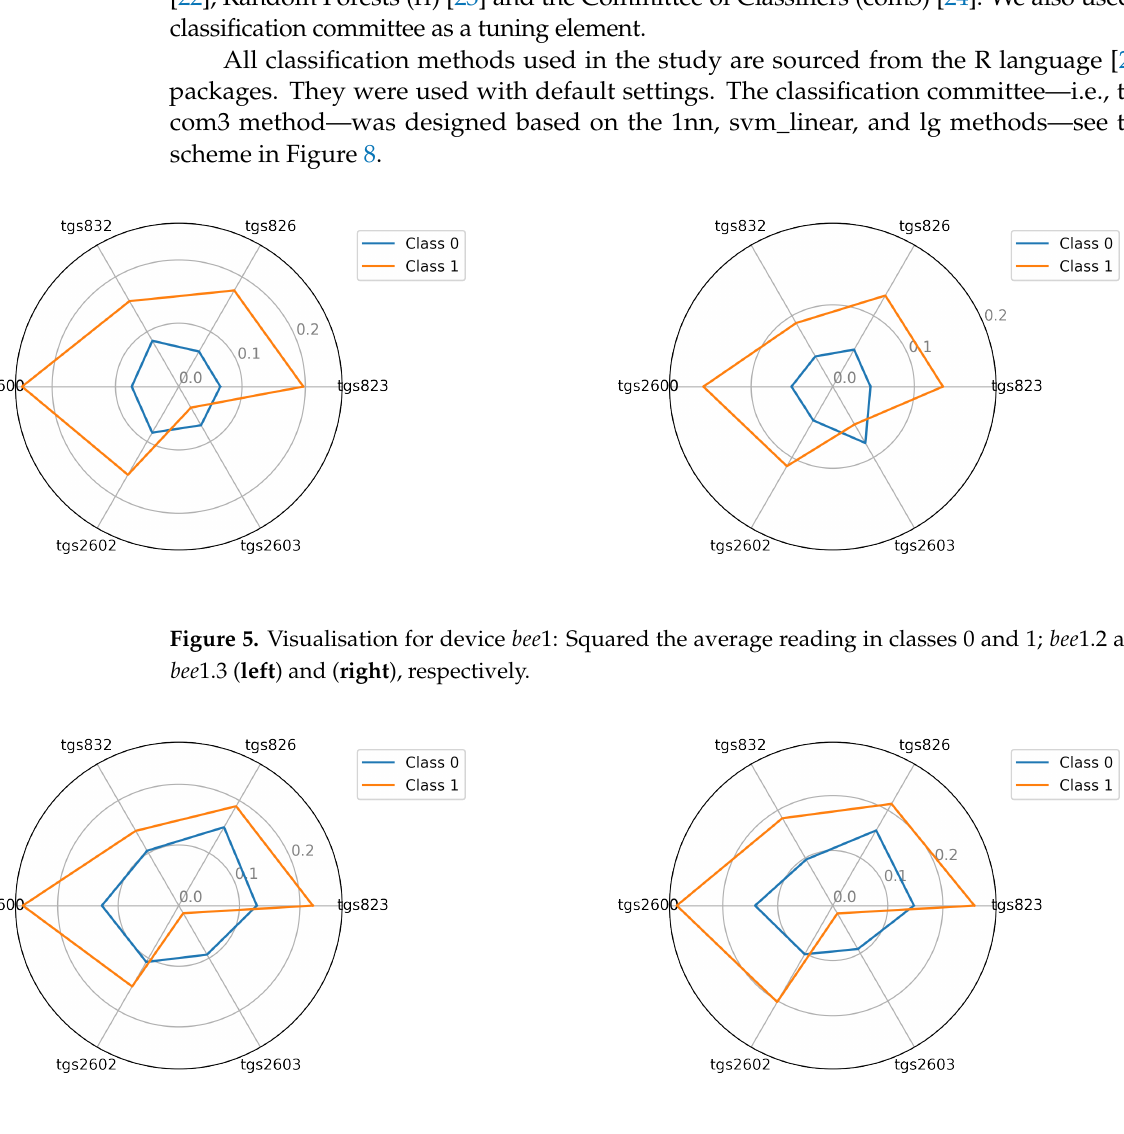
Figure 6. Visualisation for device bee 2: Squared the average reading in classes 0 and 1; bee 2.2 and bee 2.3 ( left ) and ( right ),